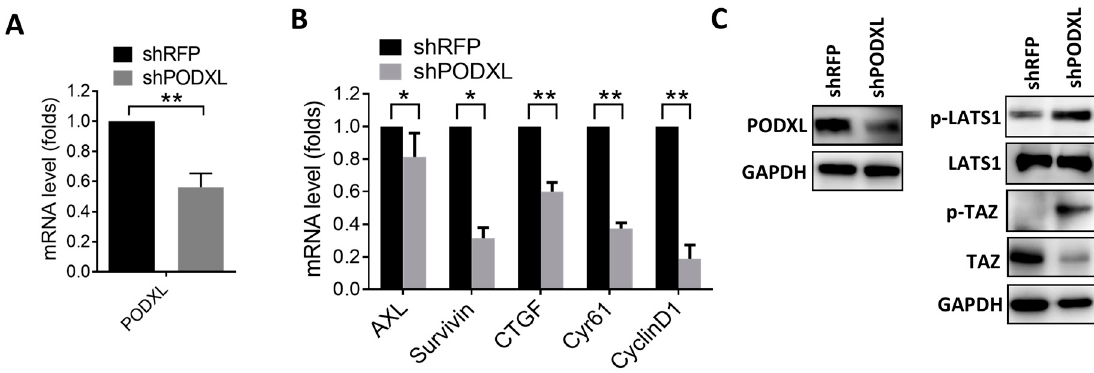
Figure 2. Suppression of PODXL decreases TAZ downstream gene expressions. ( A ) Real-time PCR analysis of the PODXL mRNA level in PODXL-knockdown HCT15 cells. ( B ) Knockdown of PODXL-downregulated TAZ downstream gene expressions, as measured by real-time PCR assay. * p < 0.05; ** p < 0.01, as assessed by an unpaired t -test. ( C ) Western blot analysis of protein levels of the Hippo cascade in PODXL knockdown HCT15 cells. GAPDH, glyceraldehyde 3 phosphate dehydrogenase; RFP, Red Fluorescent Protein.